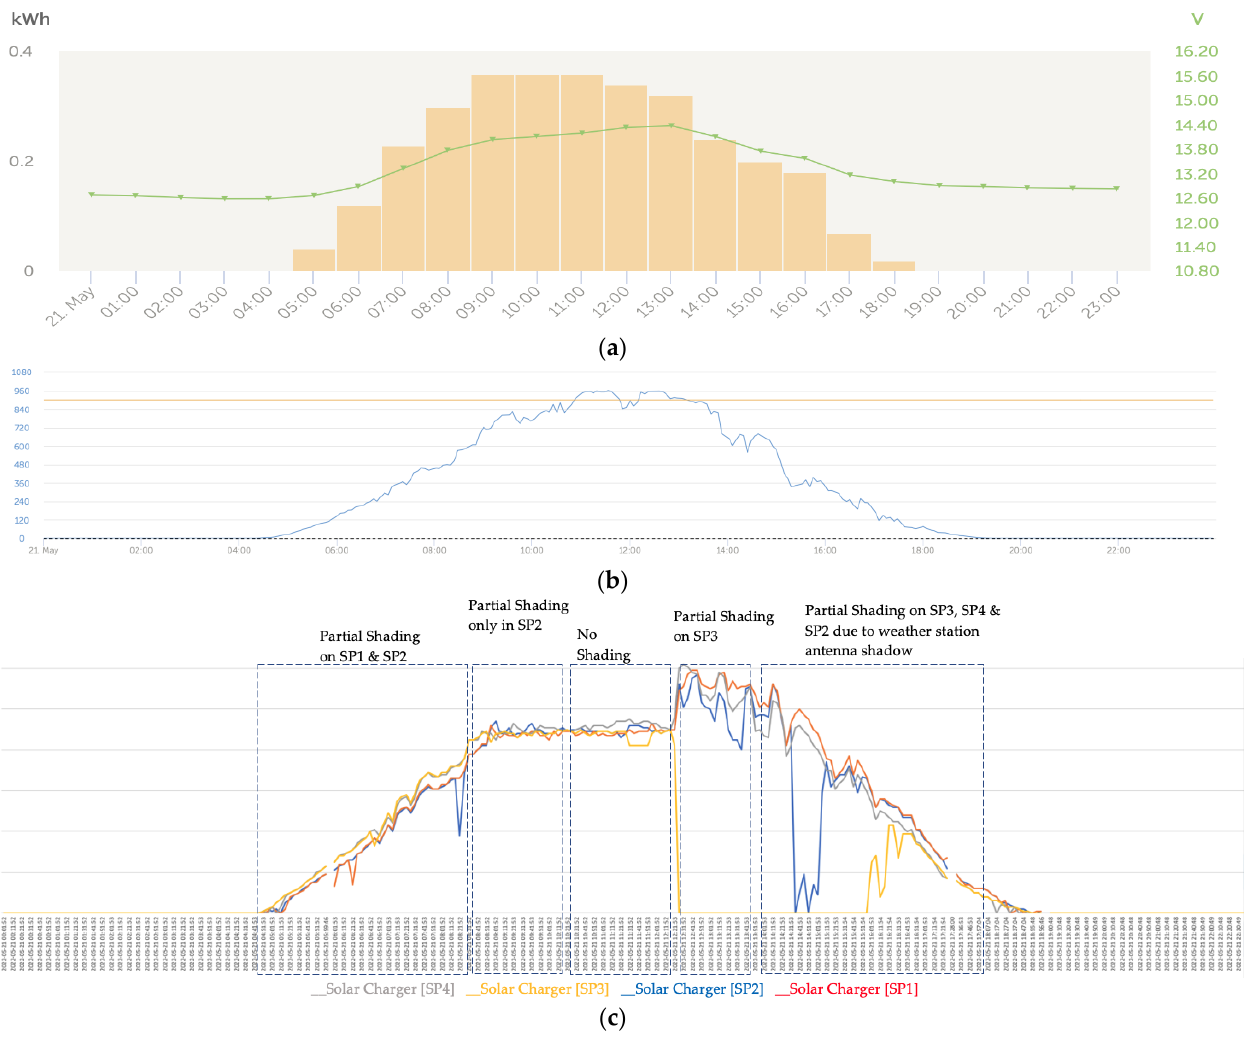
Figure 23. ( a ) Daily charge phases: initial, absorption, and flotation (15 May). ( b ) Irradiance (15 May). ( c ) Deviation Trend Comparative PV Power Data Series Analysis (15 May). ( d ) Daily partial shading displacement by the hour.